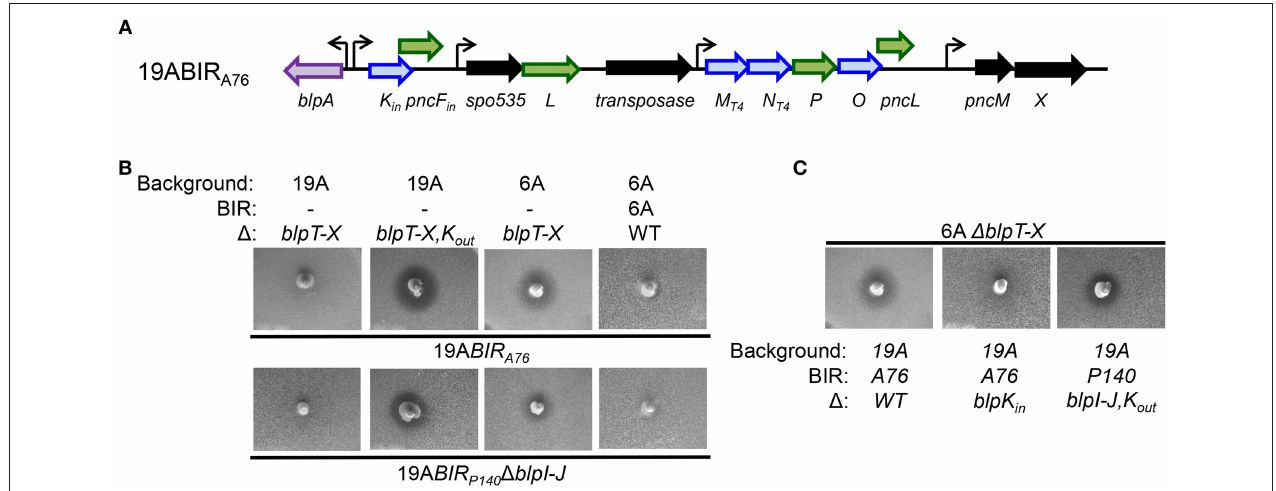
FIGURE 3 | Functional analysis of the BIR region of A76 strain after moving into a 19A strain background. (A) Schematic representation of BIR A76 . Blue arrows indicate predicted pneumocins, and green arrows indicate predicated immunity proteins. Black arrows indicate ORF encoding proteins of unclear significance. Curved arrows represent predicted transcriptional start sites based on the presence of a predicted BlpR binding site. (B,C) Overlay assays showing the inhibitory activities of BlpK-expressing stains. The properties of strains spiked into the plate are shown below the photo, overlay strains designations are shown above the